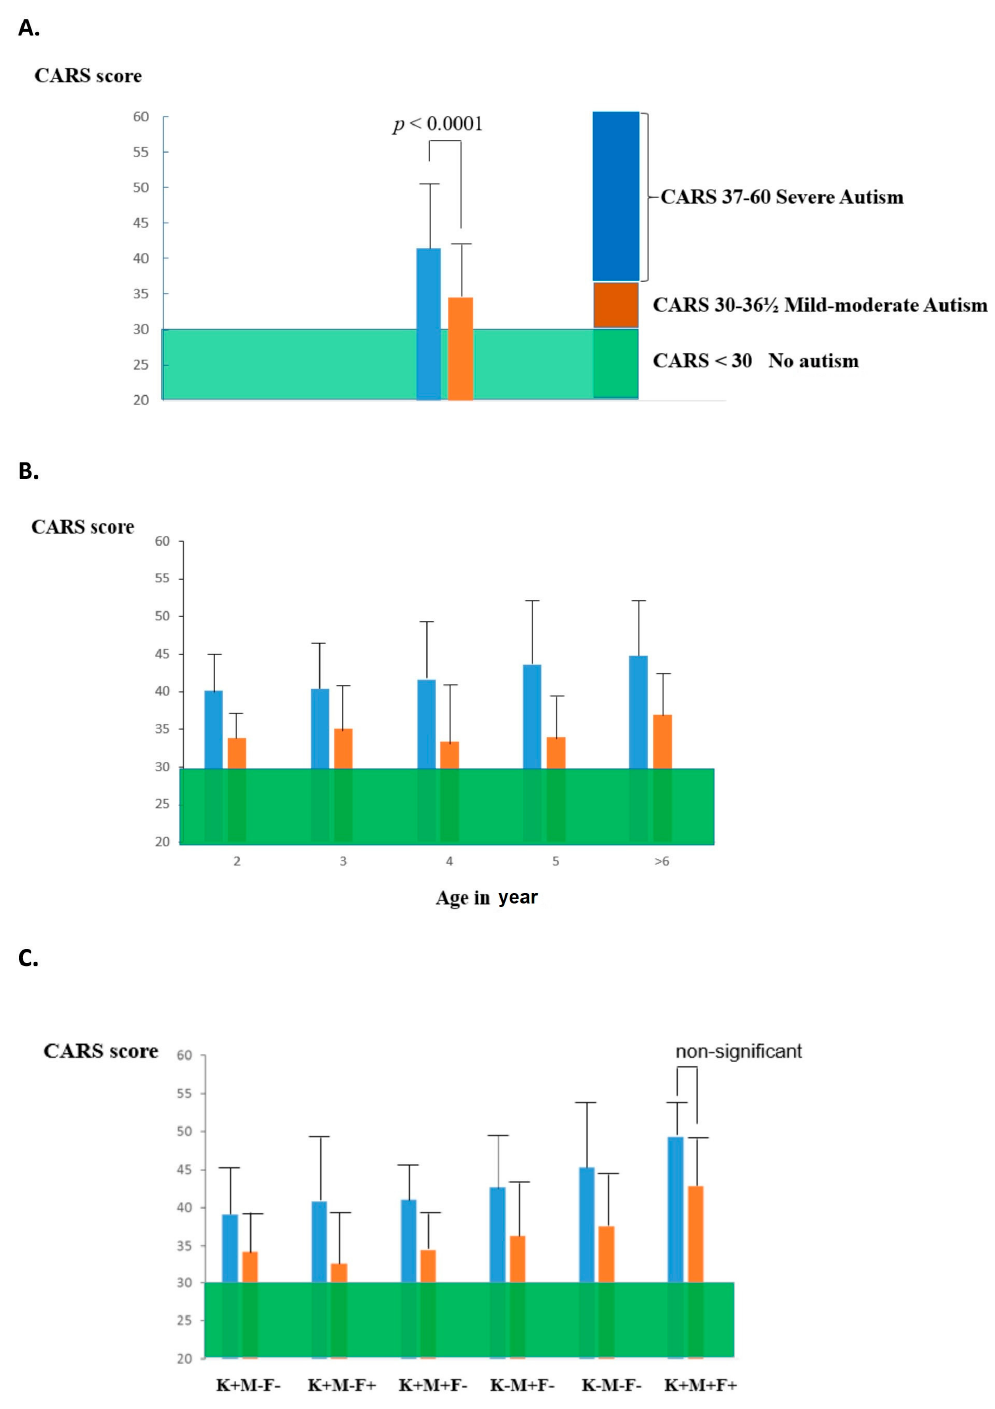
Figure 3. ( A ). Compared to untreated autistic patients ( n = 84) whose CARS remained unchanged, a group treated with folinic acid and with their nutritional deficits corrected showed a decrease in baseline CARS score from severe ( n = 82; CARS mean ± SD: 41.34 ± 6.47) to moderate or mild autism (mean ± SD: 34.35 ± 6.25; paired t -test p < 0.0001). ( B ). As a function of age, the baseline CARS (blue bars) increased slowly with advancing age, while the CARS after a 2-year treatment period (orange bars) diminished significantly for all age subgroups. The increase of baseline CARS with advancing age will adversely influence the final outcome for older age groups, particularly above 6 years. ( C ). This graph represents the outcome of treatment as a function of the particular FR α antibody profile in the child (K), mother (M) and father (F). The presence of maternal FR α antibodies or presence of antibodies in both parents will negatively affect the treatment outcome (adapted from